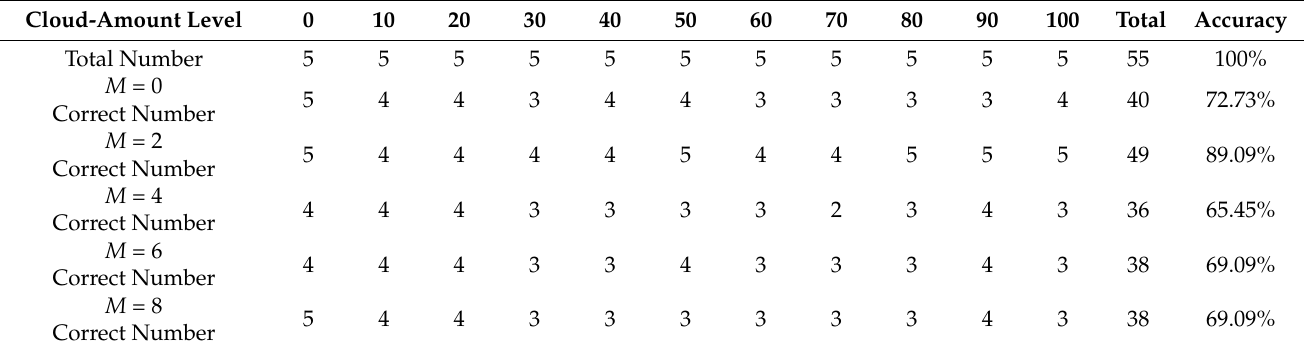
Table 2. Table of experimental results for cloud-amount level